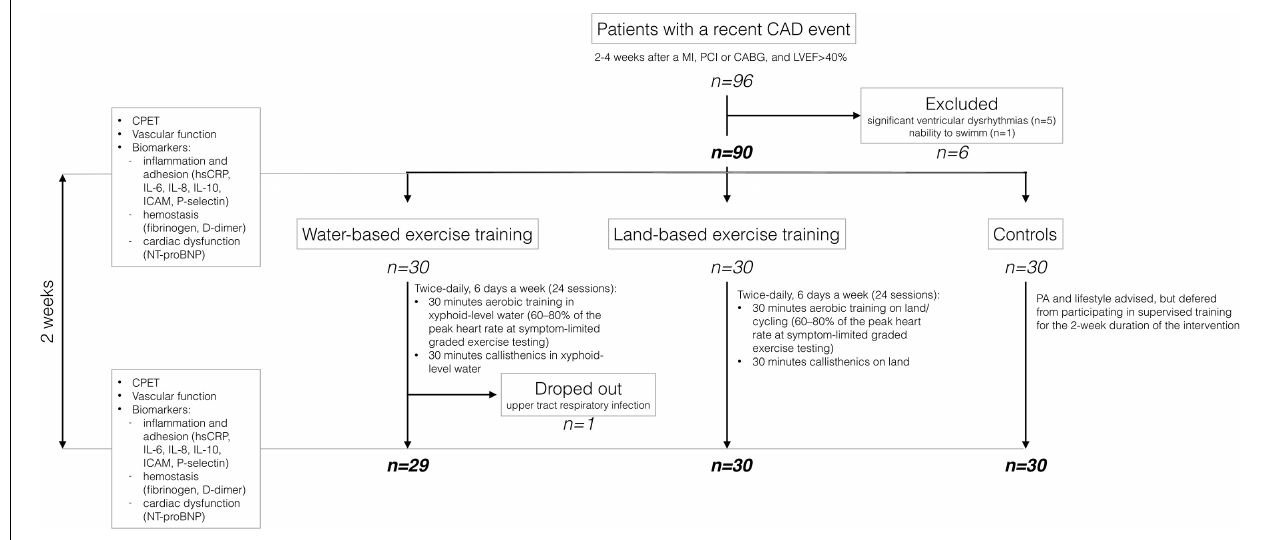
FIGURE 1 | Patient selection and study design flowchart.